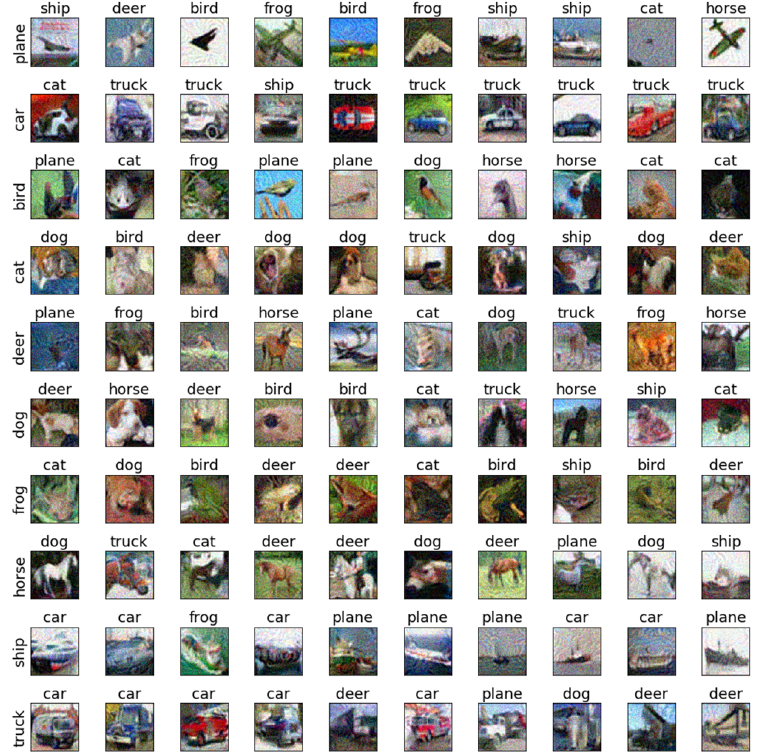
Figure 10. The adversarial examples of CW for Cifar10 and AlexNet.